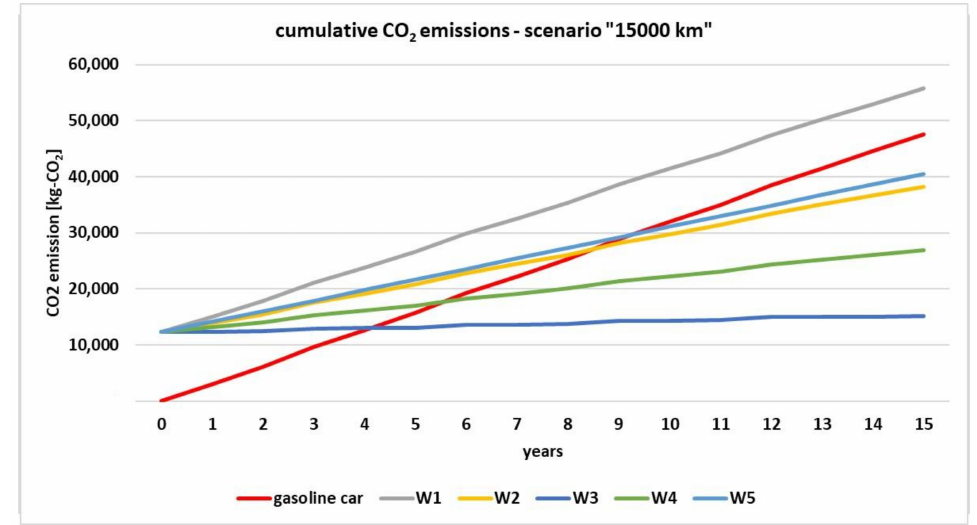
Figure 4. Comparing the cumulative CO 2 emissions for a gasoline car and an electric car in each year of operation (15,000 km/year